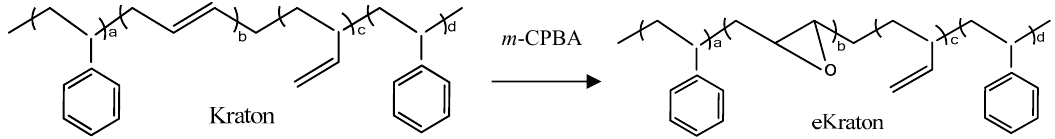
Figure 2. Simplified chemical reactions involved during the epoxidation of the star block copolymer by m ‐ CPBA.